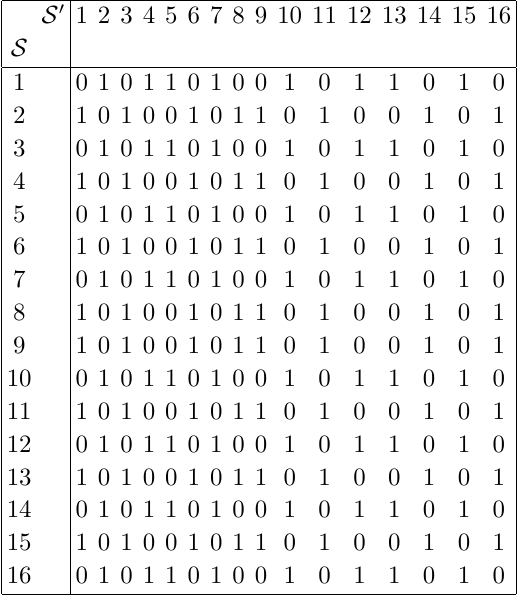
(cid:2) P with di(cid:11)erent boolean factors. [1] [2]